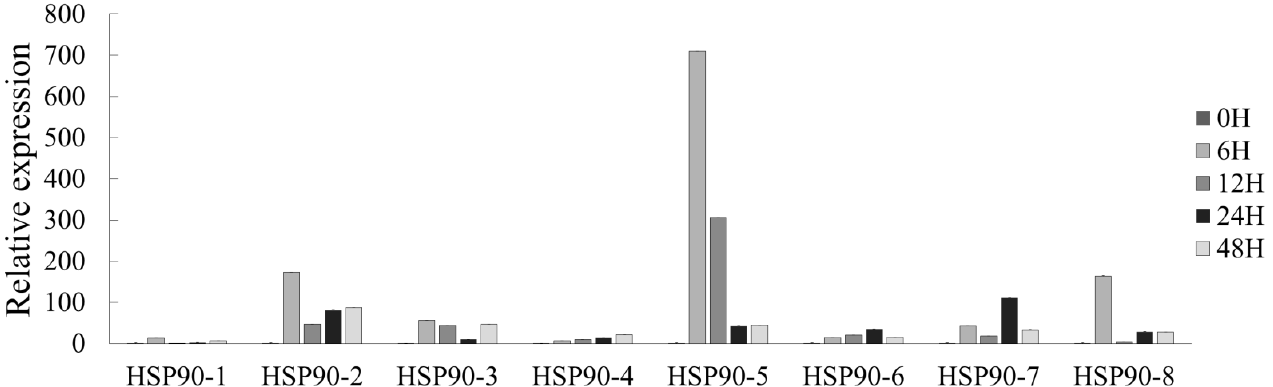
Figure 3. Expression patterns of LpHsp90s in response to heat. The values are the mean values of expression (n = 3). LpHsp90 was highly expressed under heat stress as compared to other treatments.